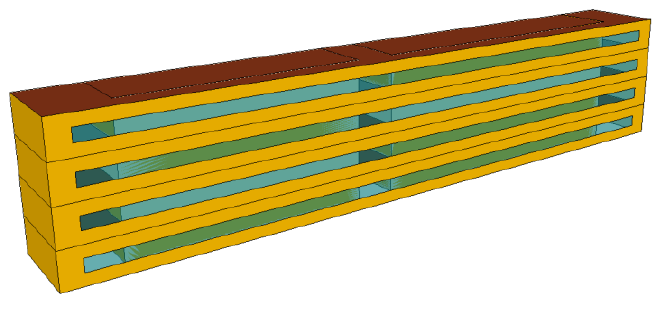
Figure 7. School Figure 7. School building. Figure 7. School building.